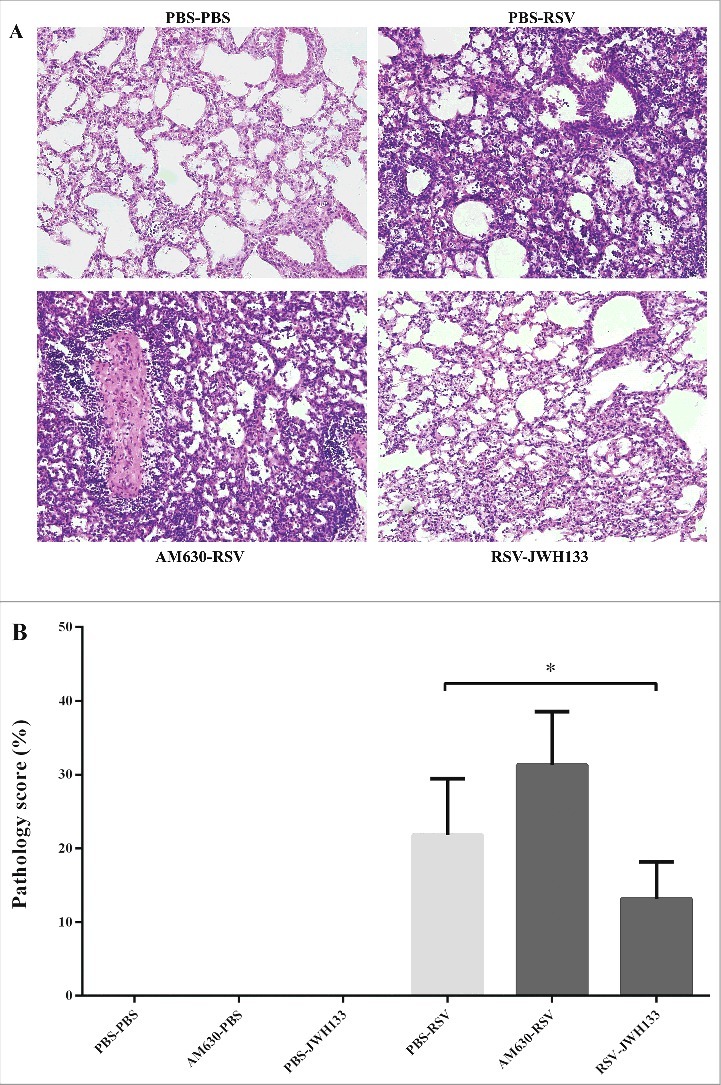
The effect of CB2 receptors on lung pathology following RSV infection. CB2 receptors were blockade via using AM630 or activated through JWH133 daily and the lung pathology were determined on day 5 after infection. (A) Representative slides of hematoxylin and eosin-stained lungs were analyzed and scored on day 5 after infection. (B) Pathology scores percentage for each group are shown. Results represent the mean ±SEM of 6 animals for each group. (*p < 0.05).